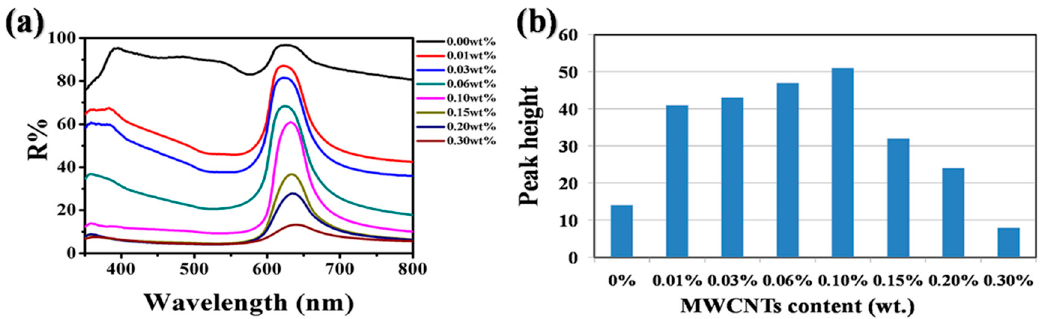
Figure 4. ( a ) Reflectance spectra of the PS/MWCNTs films with different MWCNTs content (PS particle size was 317 nm); ( b ) Corresponding reflection peak intensity contrast.